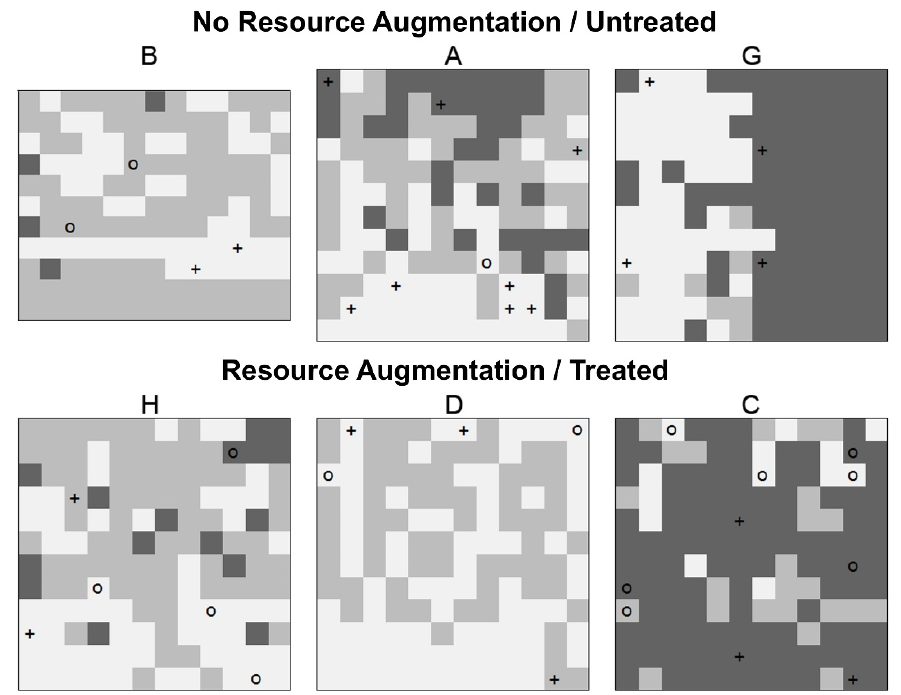
Figure 4. Hierarchical clustering based on environmental characteristics measured per trapping station. Hierarchical clustering revealed fine-scale habitat clusters based on environmental characteristics measured per trapping station (Cluster 1, light gray; Cluster 2, gray; Cluster 3, dark gray). The vegetative indices were sampled during June–July (winter, dry season) of 2015. The grids were previously classified by overall habitat degradation (left to right: least degraded, Grids B and H ; moderate degradation, Grids A and D ; and most degraded, Grids G and C ) for untreated grids (top row) and grids with resource augmentation (“Treated”, bottom row, Grids H , D , and C ). Circles show the location of antibody-positive A. montensis , and “+” show the locations of all other rodent species with hantavirus-reactive antibodies.